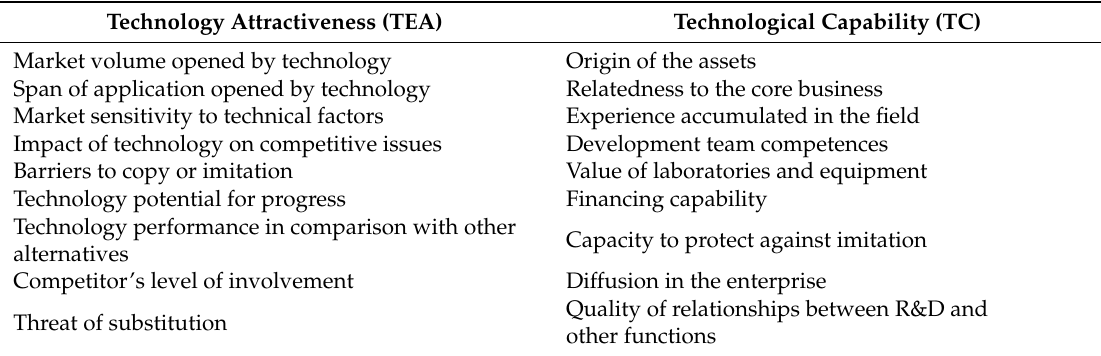
Table 2. Criteria of technology assessment.